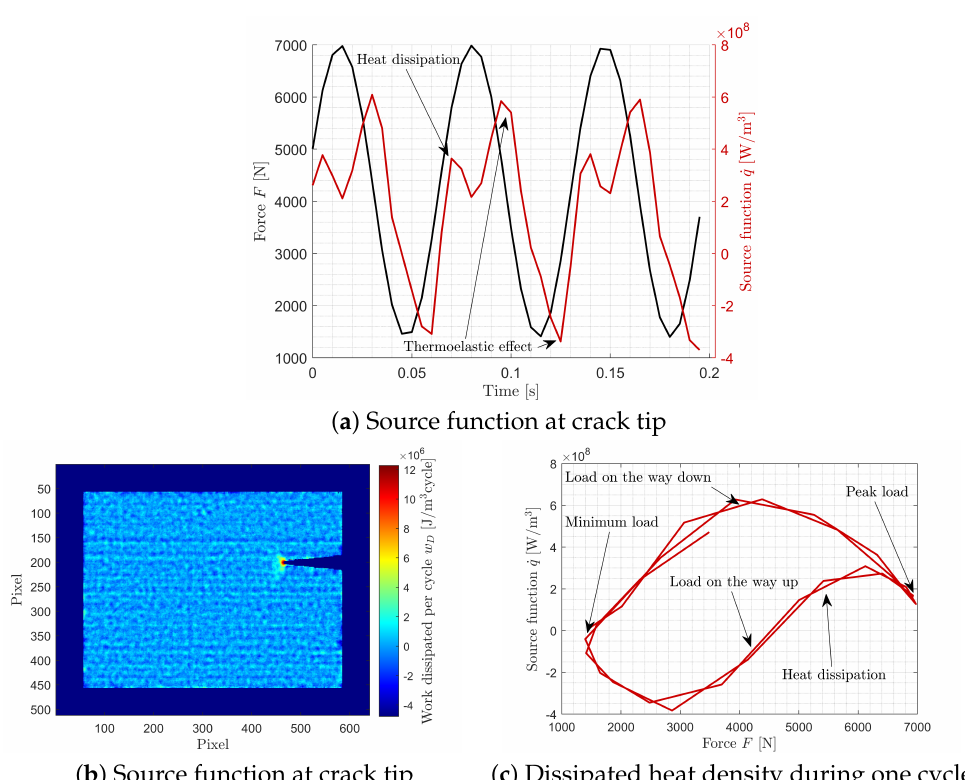
Figure 18. The source function plotted versus time ( a ) or loading force ( b ): the contributions from the heat dissipation and thermoleastic effect are distinguished, and the separated heat energy dissipation per cycle is shown in ( c